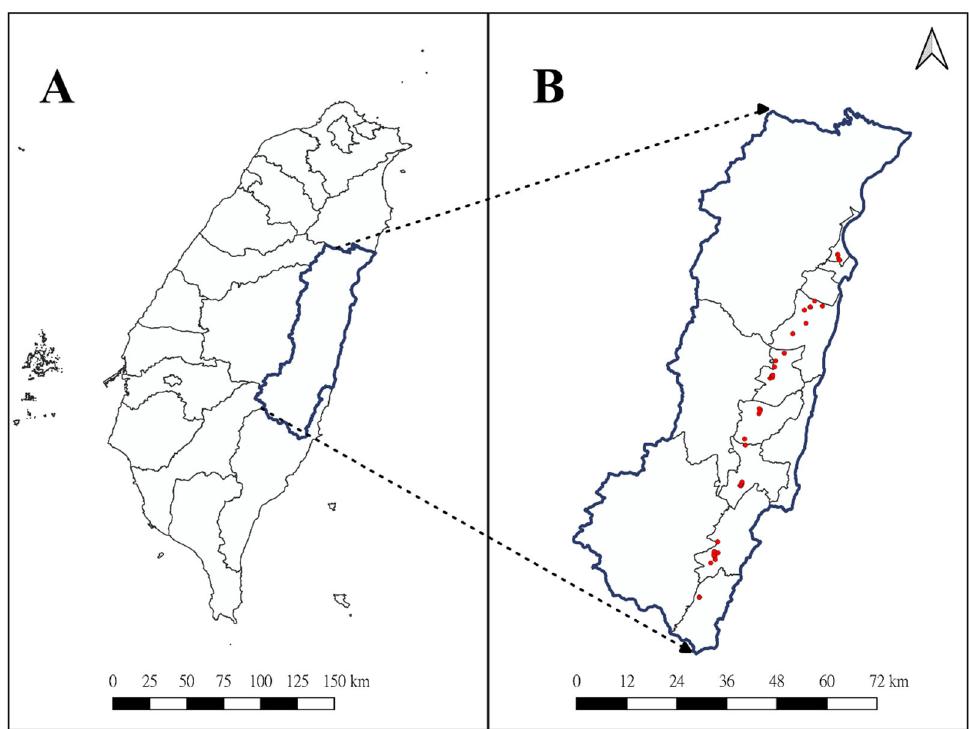
Figure 1. Location of Hualien County in Taiwan ( A ) and that of sampling houses in Hualien County ( B ).